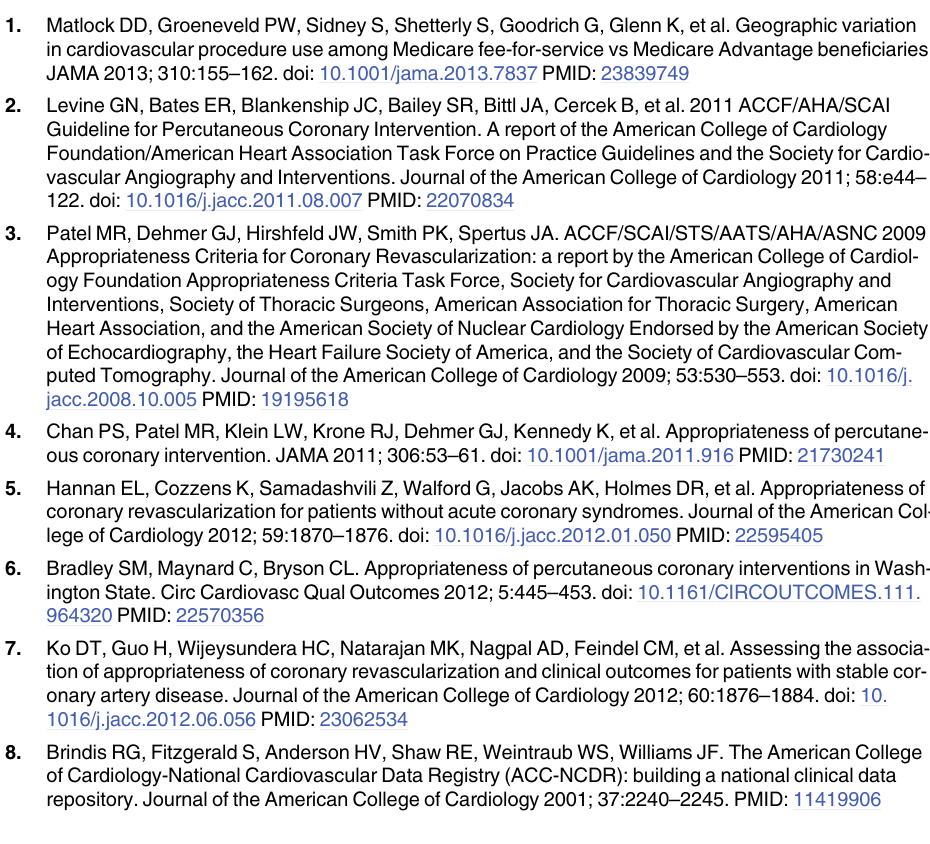
S2 Fig. Distribution of PCI appropriateness across quintiles of HRRs with 100% pene- trance of the CathPCI Registry. S3 Fig. Appropriate use criteria categorization of PCIs across quintiles of HRRs with 100% penetrance of the CathPCI Registry. S4 Fig. Appropriate use of PCI by quintile for acute PCIs of HRRs with 100% penetrance of the CathPCI Registry. S5 Fig. Appropriate use of PCI by quintile for non-acute PCIs of HRRs with 100% pene- trance of CathPCI